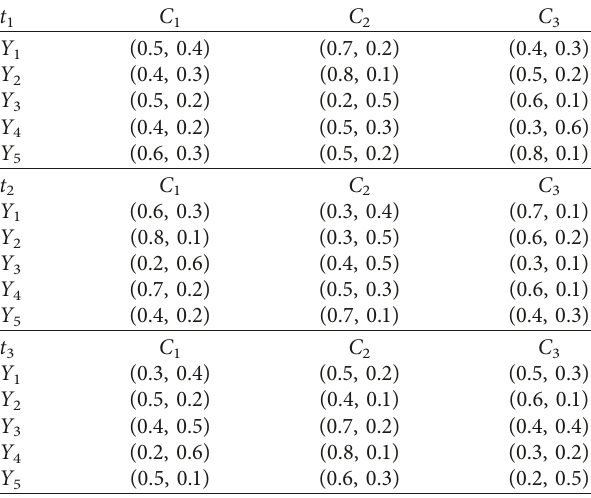
Table 1: Intuitionistic fuzzy matrix in different periods.